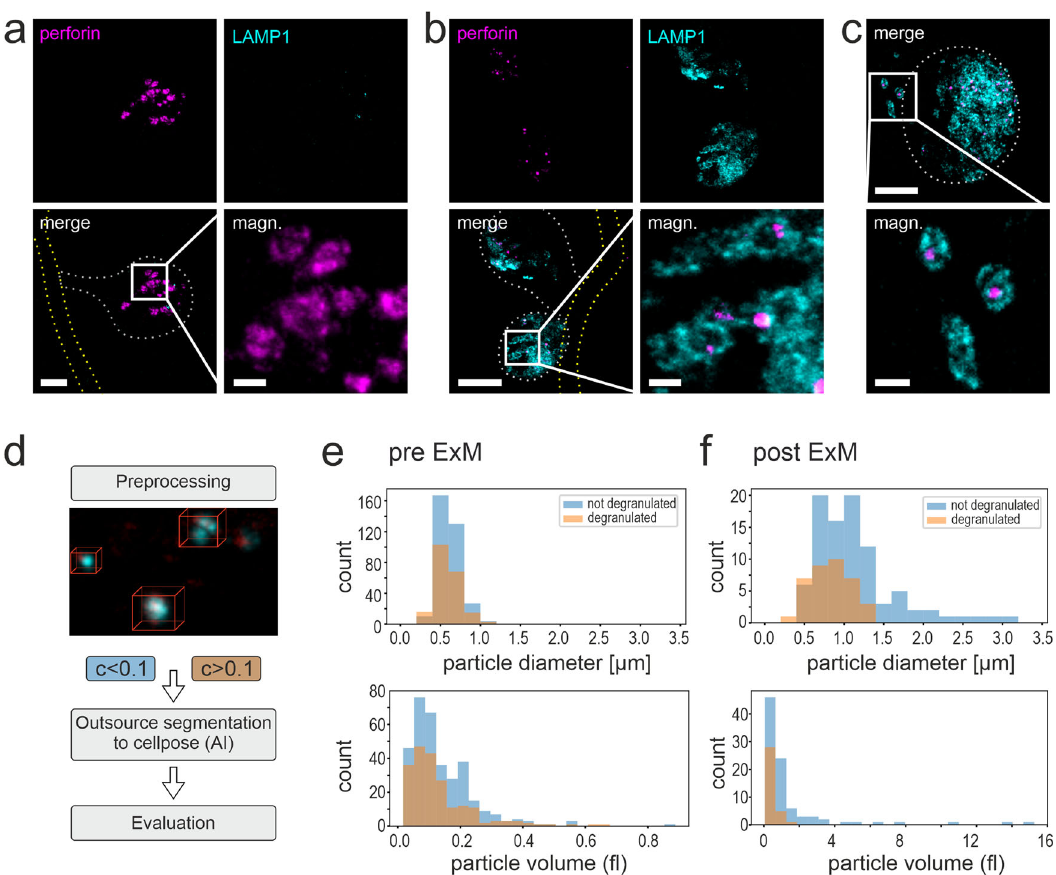
Fig. 5 Visualization of NK-cell degranulation by ExM and computation analysis of granule size pre-/post-ExM. Non-degranulated NK cells ( a ) that remain negative for LAMP1 surface marker protein (cyan) show perforin structures (magenta) in a ring-like shape (see a magni fi cation of the indicated box for details). Degranulated NK cells ( b , c ) show a high concentration of LAMP1 protein at the surface during degranulation ( b ) and perforin surrounded by LAMP1 is frequently observed ( c ). Note the differences in the size of perforin accumulation in a and b , c . NK cells were cocultured with A. fumigatus hyphae for 2.5 h and then treated with BFA for 2 h. All images shown represent maximum intensity z-projections of all slices with exception (magn. in b , z projection of slices 9 – 14). Dotted lines indicate borders of NK cells (gray) and fungal hyphae (yellow). Scale bars, 10 µ m ( a – c ) and 2 µ m in magni fi